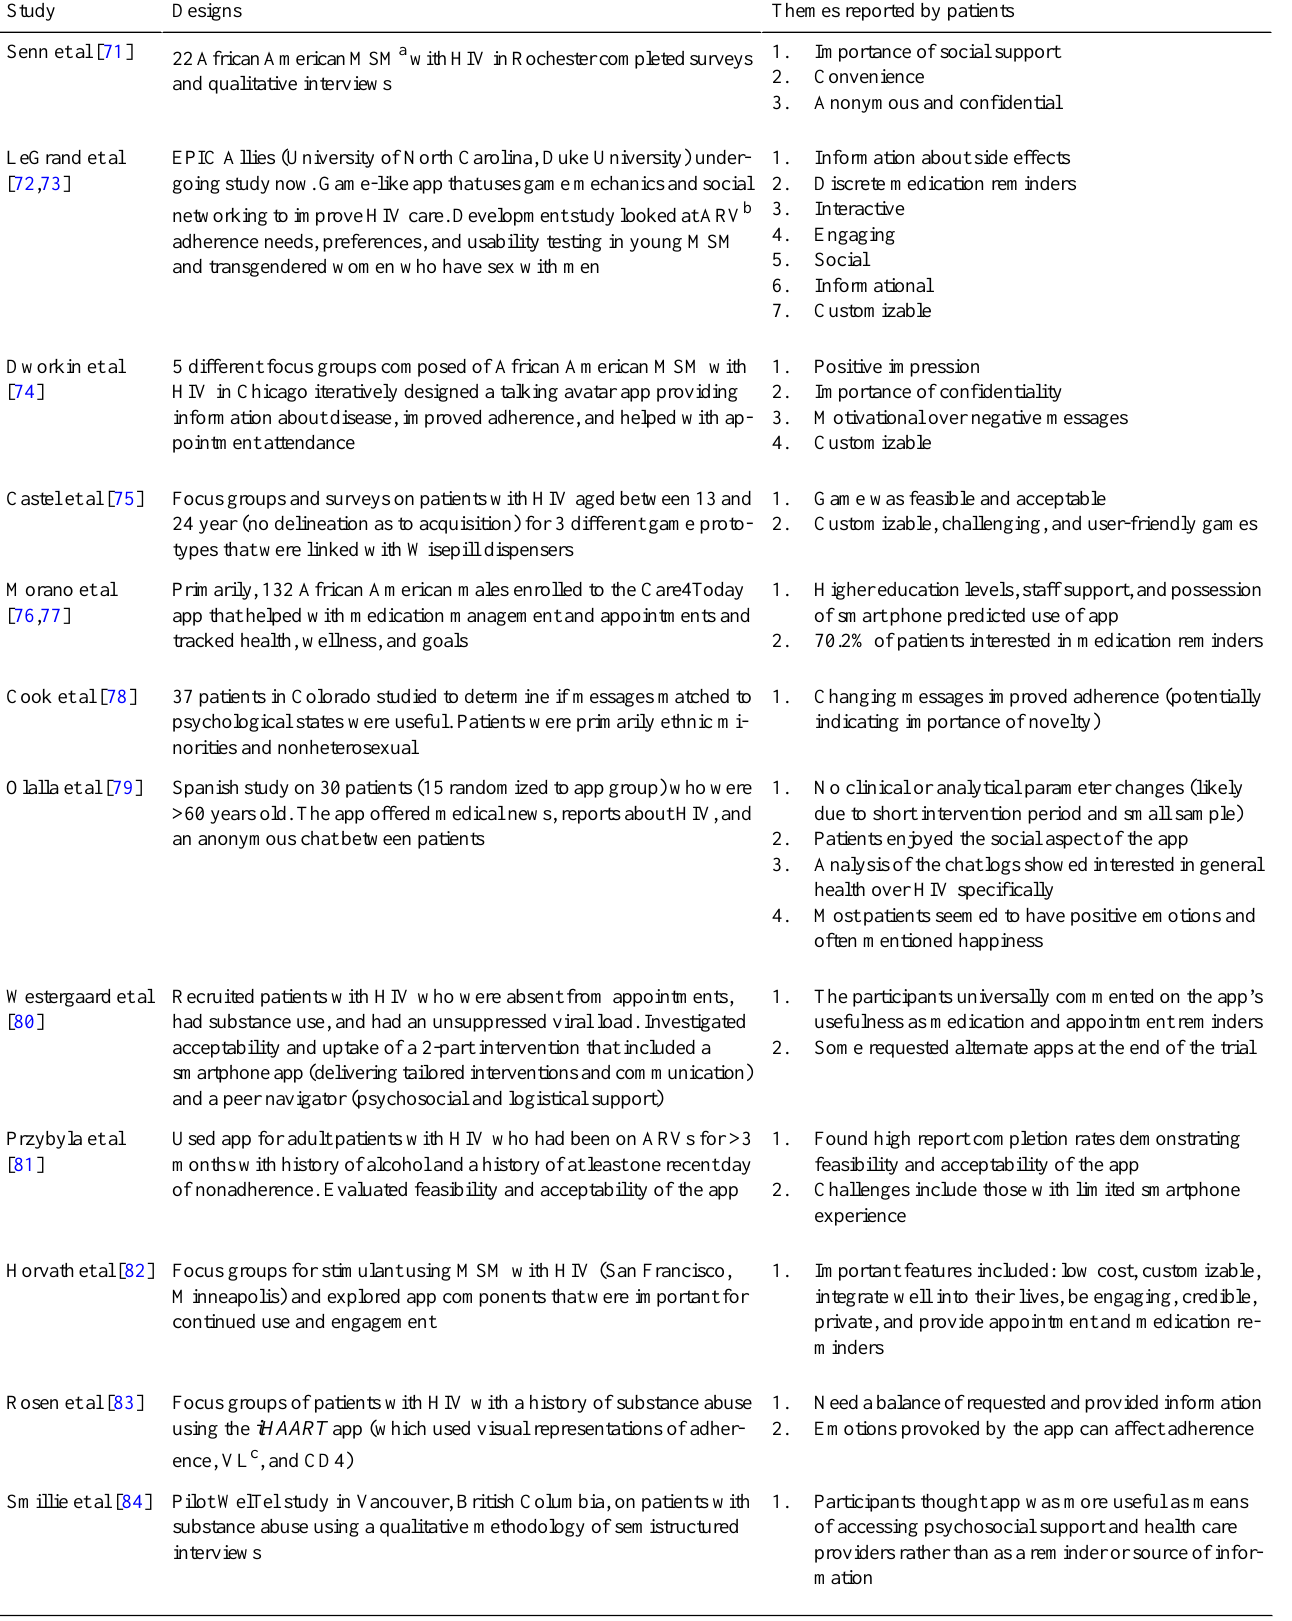
Table 2. Qualitative studies on the priorities and important themes in mobile health interventions.